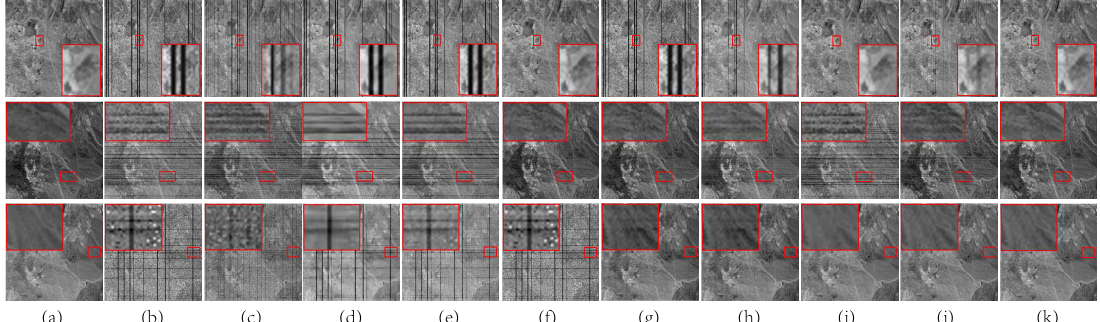
Figure 5. From top to bottom: restoration results of band 49, 11 and 74 of the RemoteImage HSI dataset under Case 3, Case 4 and Case 6, respectively. ( a ) Original HSI; ( b ) Noisy HSI; ( c ) SVD; ( d ) BM4D; ( e ) TDL; ( f ) WNNM; ( g ) WSNM; ( h ) LRMR; ( i ) LRTV; ( j ) NMoG; ( k ) DP-GMM.